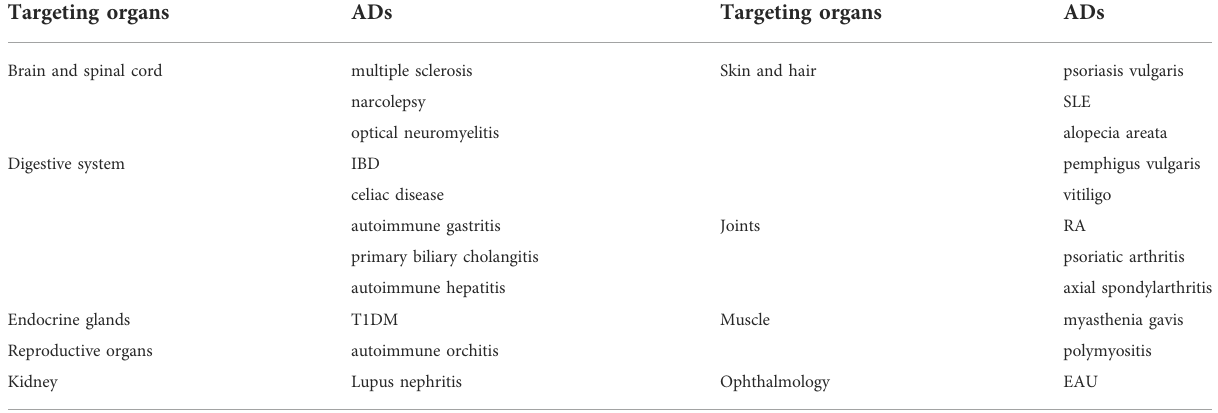
TABLE 1 Typical systemic or organ-speci fi c ADS (Wu et al., 2021). Targeting organs Brain and spinal